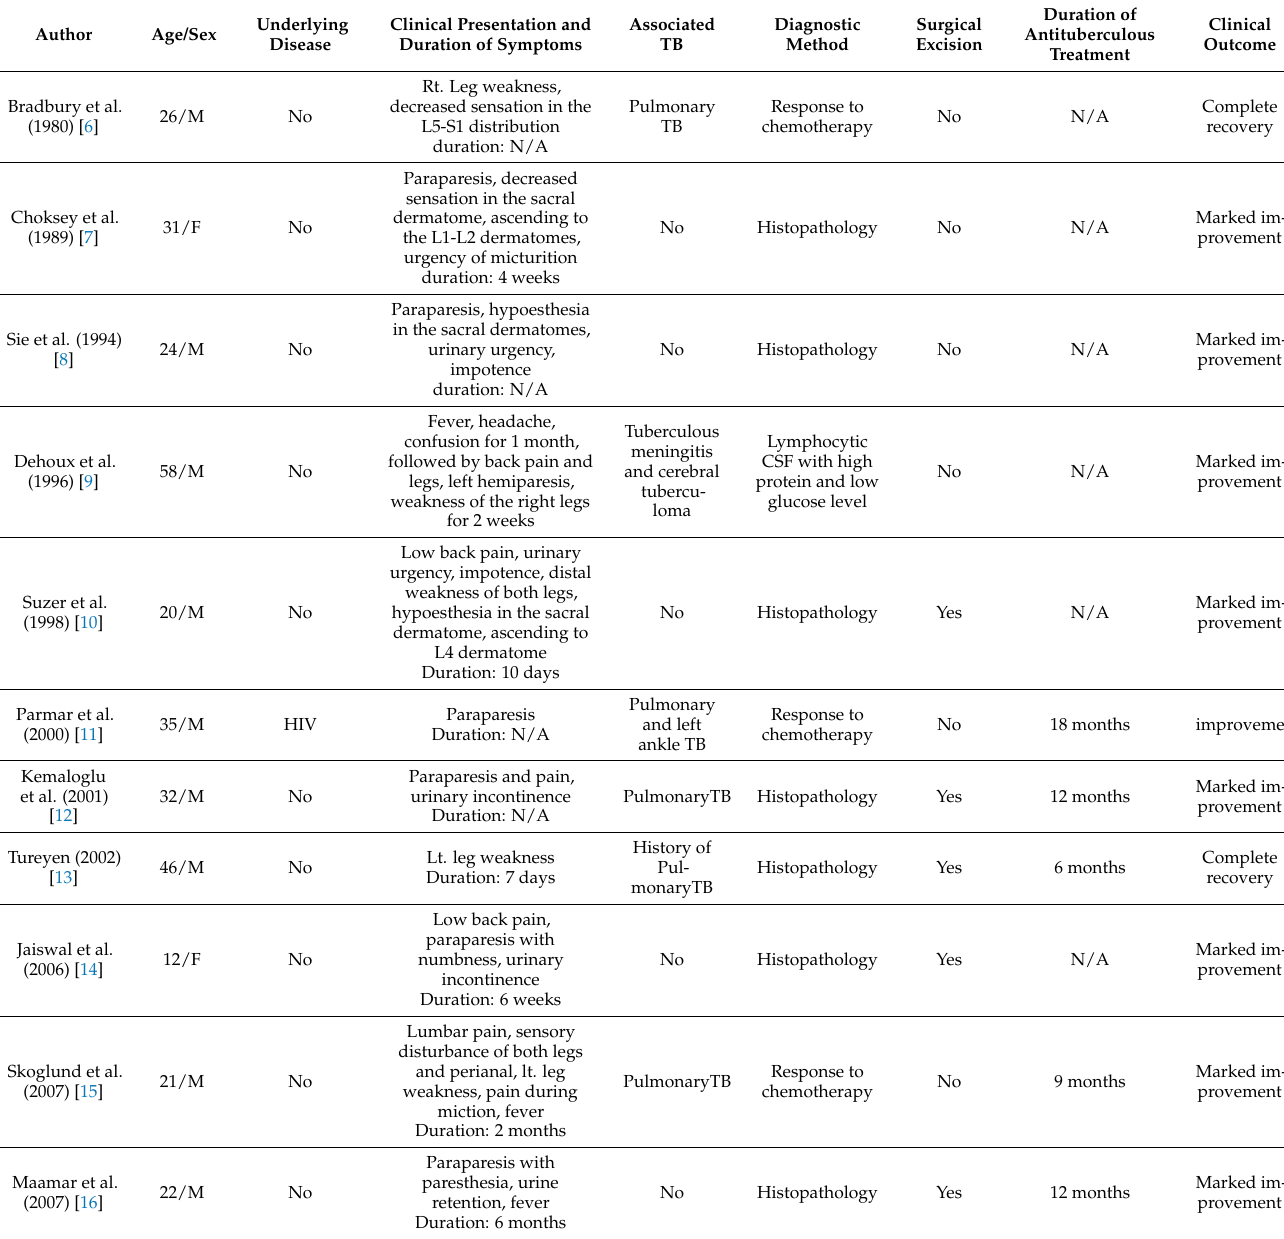
Table 1. Clinical features of patients with intramedullary tuberculoma of the conus